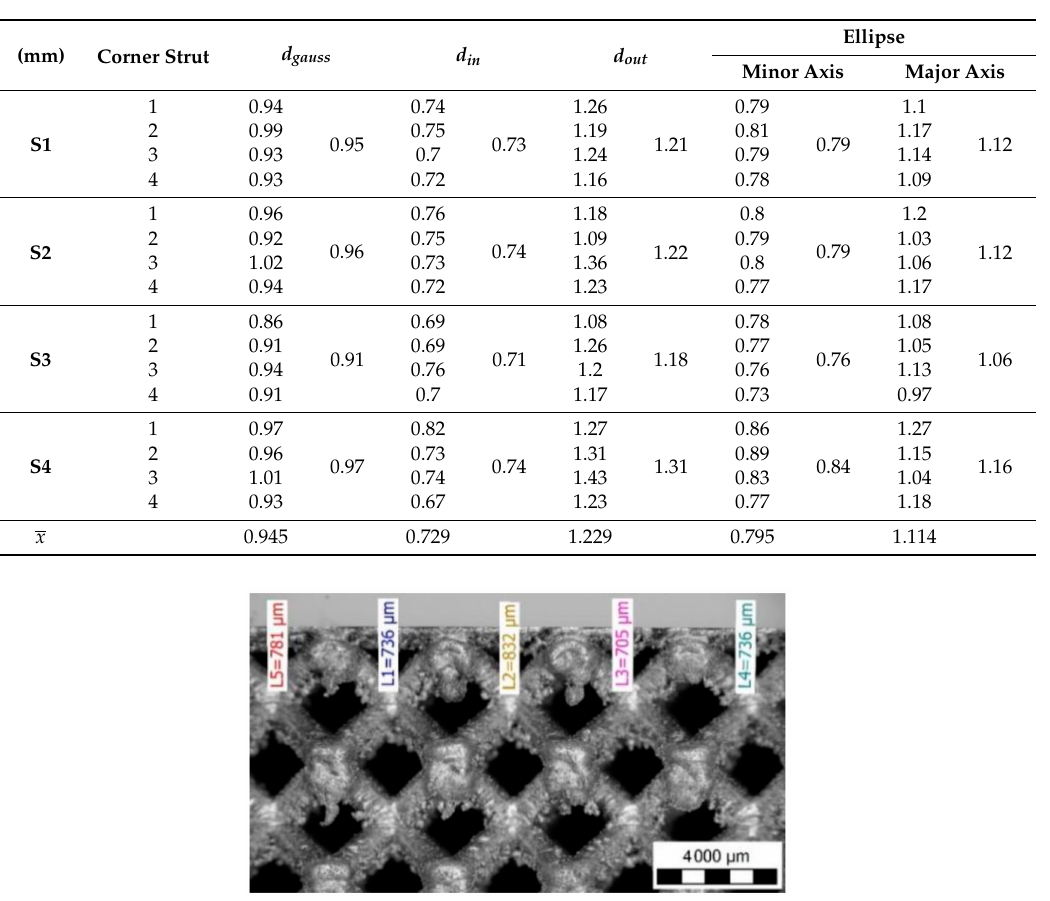
Table 3. Struts diameter measured using the Atos Triple Scan optical system (O-series; nominal diameter d = 0.8 mm).